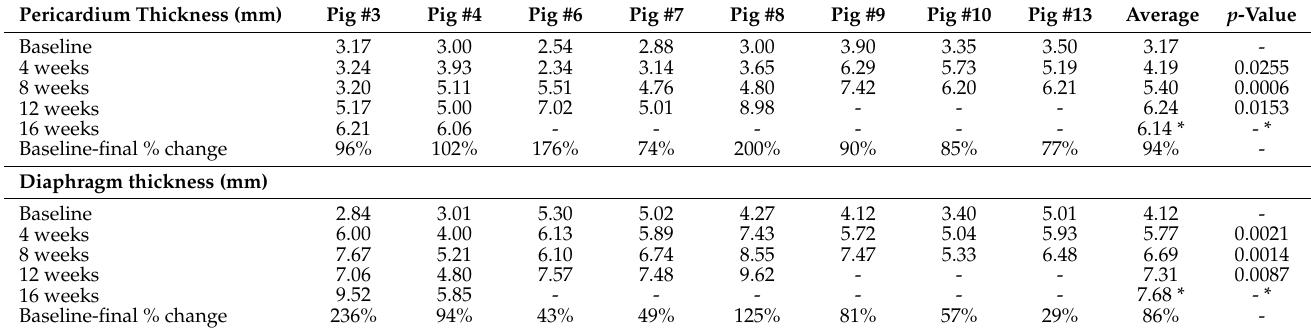
Table 2. Change in pericardium and diaphragm thickness throughout follow up.